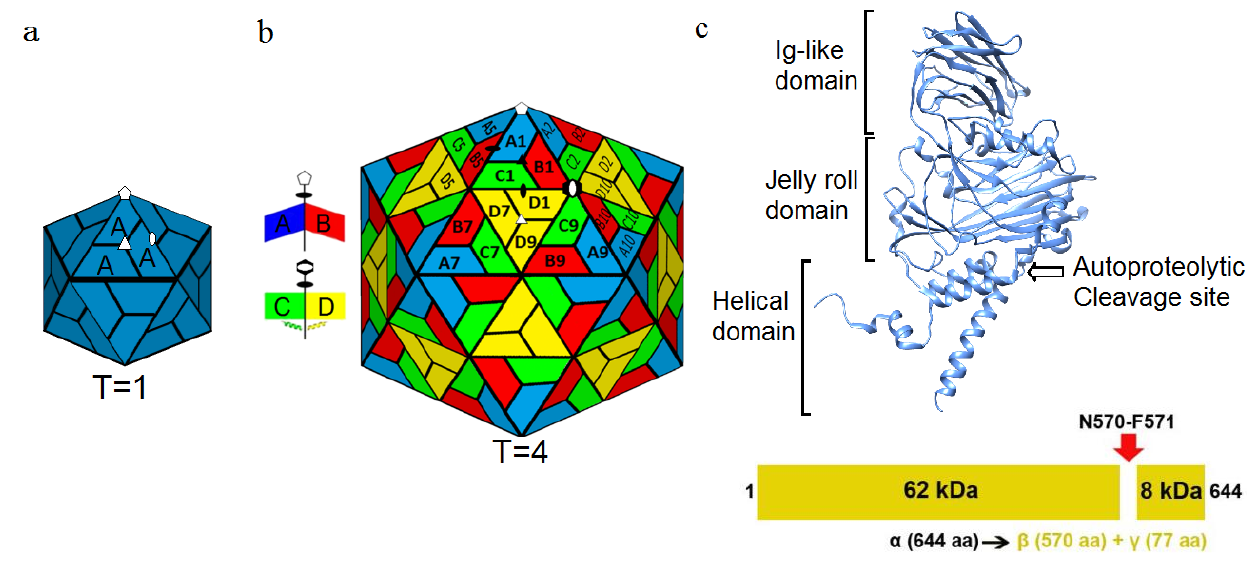
Figure 1. Icosahedral arrangement of capsid proteins. ( a ) The T = 1 surface lattice where 60 copies of a single gene product are used to form a complete capsid. White symbols identify icosahedral 5-fold (pentagon), 3-fold (triangle), and 2-fold (ellipse) symmetry axes; ( b ) The T = 4 surface lattice seen in NωV where an asymmetric unit containing 4 copies of a single gene product forms the icosahedron (240 total protein subunits). Local environments allow for quasi-symmetry in addition to the standard icosahedral symmetry elements. Dimer interfaces at the quasi-2-fold axes occur with either bent (A–B) or flat (C–D) conformations. White symbols identify icosahedral symmetry axes, and black symbols identify quasi-2-fold (ellipses) and quasi-3-fold (triangle) axes. The hexagon with the white ellipse embedded identifies a quasi-6-fold symmetry axis (icosahedral 2-fold axis); ( c ) Schematic of the α protein that makes up the capsid. The capsid protein is comprised of the N-terminal and C-terminal helical domain which interacts with the RNA, the Jelly roll domain and the Ig-like domain on the surface of the capsid.